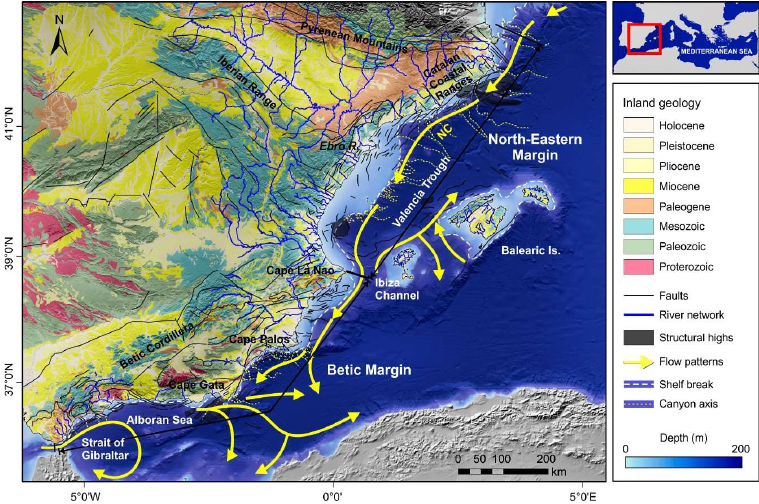
Figure 1. Shaded-relief map of the Mediterranean margin of the Iberian Peninsula showing inland geology and the gross bathymetry of the continental margin. The offshore structure was synthesized from previous works [23,35–37]. The inshore structure and lithology were adapted from the One Geology Project (http://www.onegeology.org/). The topographic data were provided by the Spanish National Geographic Institute (www.ign.es). The bathymetric data were extracted from the EMODnet portal (http://portal.emodnet-bathymetry.eu/) and the Catalano-Balearic Sea bathymetric chart [38]. Sea surface circulation patterns were compiled from several studies [28,39]. NC: Northern Current. The southeastern part of the Iberian Peninsula is marked by an arid climate, with extreme temperatures and scarce rainfall. Consequently, even the major rivers (Segura, Almanzora) feeding the Northern and Southern arcs exhibit seasonal and highly irregular flow regimes. The northern margin of the Alboran Sea is fed by abundant short, steep river systems that exhibit a torrential character and marked seasonality and are very efficient in transporting sediments toward the marine realm [40,41]. The longest rivers from east to west are Andarax, Adra, Guadalfeo, Guadalhorce and Guadiaro. The shallow-water circulation between La Nao and Gata capes is affected by the southwestward movement of the NC, that continues south of the Ibiza Channel, but with less energy and increasing mesoscale variability [26,28] (Figure 1). In contrast, the surface circulation in the Alboran Sea exhibits two anticyclonic gyres. Overall, the inflow of recent MAW at depths shallower than 200 m along the northern margin of the Alboran Sea is directed eastward and is separated by denser outflowing water masses by the Almeria-Oran front [26,28]. Shelf current patterns may be reversed according to variable wind conditions, attaining velocities of 0.1–0.15 m/s [42]. 3. Materials and Methods 3.1. Characterization of Shelf Growth Patterns To provide an overview of the regional variability of shelf growth patterns along the Iberian Mediterranean margin, we have used two types of data: (a) Bathymetric data covering the continental margins along the Mediterranean side of the Iberian Peninsula were extracted from the EMODNET portal (http://www.emodnet-bathymetry.eu)